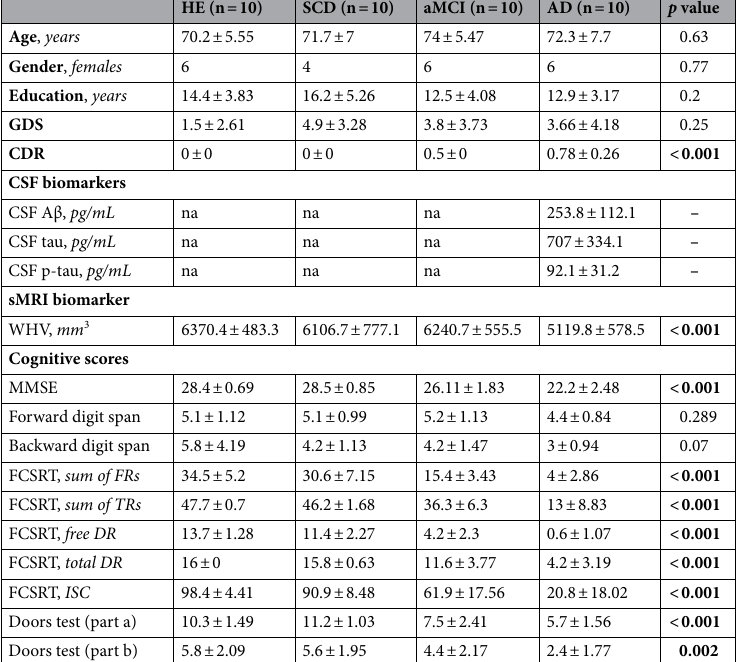
Table 1. Participants’ demographic and clinical data. Values are presented as mean ± SD (standard deviation). Statistically significant group effects are indicated in bold. Group effects were assessed with ANOVA test 2 for continuous variables and with χ (Pearson) for categorized indices. Normal values of CSF Aβ: > 381 pg/ mL. Normal values of CSF tau: < 437 pg/mL. Normal values of CSF p-tau : < 61 pg/mL. HE healthy elders, SCD subjective cognitive decline, aMCI amnestic mild cognitive impairment, AD Alzheimer’s disease